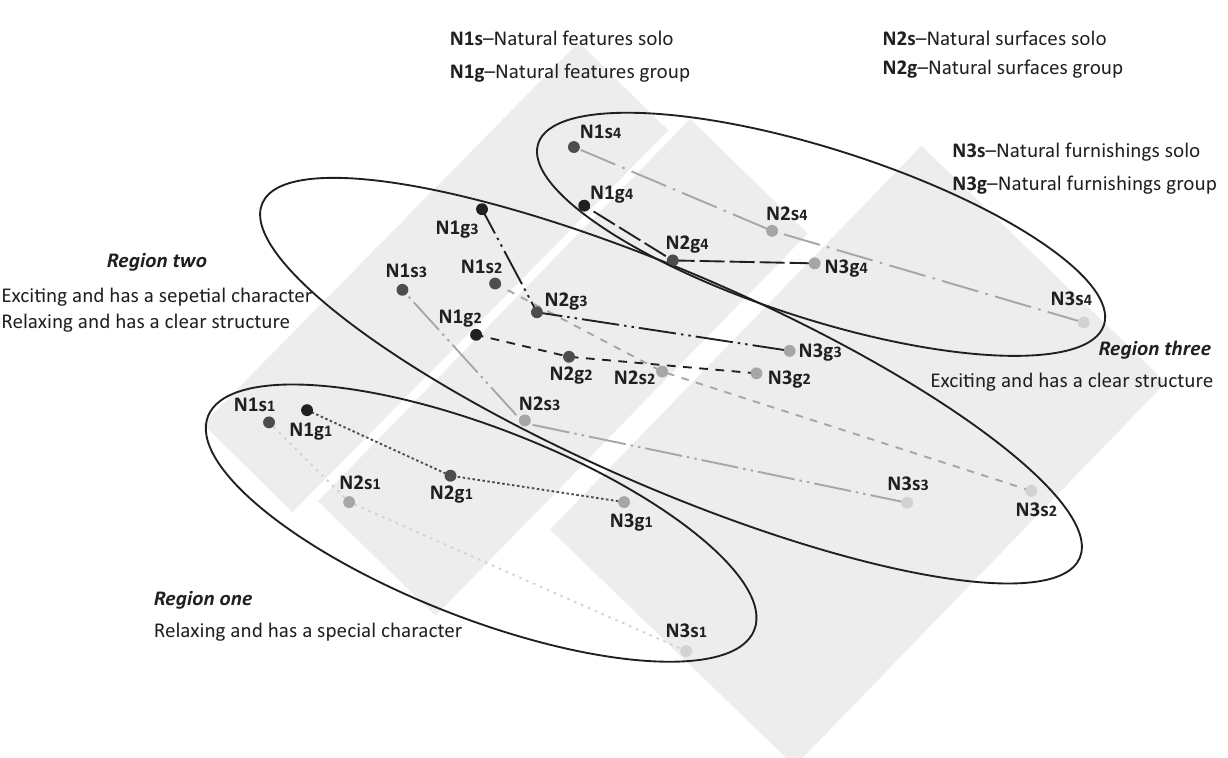
Figure 3. Two-dimensional spatial representation of 24 natural design elements classified by design feature, behaviour, and cognitive-affective affordance (stress = 0.14; N = 158). Grey areas represent the three design elements, features, surfaces and furnishings.